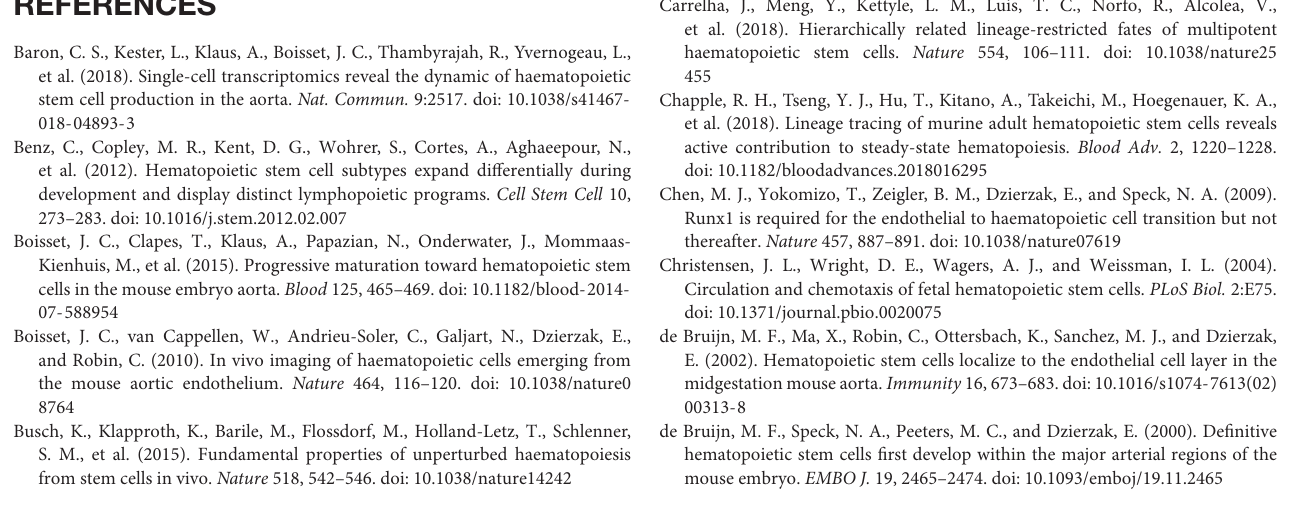
Supplementary Figure 2 | Representative FACS analyses of Hlf-tdTomato expression in embryos. (A) Representative FACS plots showing the proportions of Hlf-tdTomato + cells in hematopoietic cells (CD41 + /CD43 + /CD45 + ) and non-hematopoietic cells (CD41 − CD43 − CD45 − ) of the limb, head, and trunk from E10.5 Hlf-tdTomato embryos. Data are representative of two independent experiments. (B) Representative FACS plots showing no Hlf-tdTomato expression in PK44 (CD41 − CD43 − CD45 − CD31 + CD44 + Kit + CD201 + ) population of the E10.5 Hlf-tdTomato AGM region. Supplementary Figure 3 | Representative FACS analyses of multi-lineage repopulation in multiple organs. (A) Representative FACS plots showing multi-organ and multi-lineage repopulation in the recipients 16 weeks post-transplantation transplanted with the culture products of the indicated cell populations from the E10.5 AGM region. The myeloid cells (Gr1/Mac-1 + ), B cells (B220 + ), and T cells (CD3 + or CD4/CD8 + ) in multiple hematopoietic organs are shown. (B) Representative FACS plots showing the proportions of donor-derived cells (represented by CD45.1 + ) in hematopoietic stem progenitor populations in the bone marrow of the reconstituted recipients 16 weeks post-transplantation transplanted with the progenies of the indicated cell populations from the E10.5 AGM region. LSKSLAM marker combination was used. (C) Representative FACS plots showing multi-organ and multi-lineage repopulation in the recipient 16 weeks post-transplantation transplanted with the progenies of the indicated cell populations from the E10.5 AGM region. The myeloid cells (Gr1/Mac-1 + ), B cells (B220 + ), and T cells (CD3 + or CD4/CD8 + ) in multiple hematopoietic organs are shown. (D) Representative FACS plots showing the proportions of donor-derived cells (represented by CD45.1 + ) in hematopoietic stem progenitor populations in the bone marrow of the reconstituted recipient 16 weeks post-transplantation transplanted with the progenies of the indicated cell populations from the E10.5 AGM region. LSKSLAM marker combination was used. LT-HSC, long-term hematopoietic stem cell; ST-HSC, short-term hematopoietic stem cell; MPP, multipotent progenitor; CMP, common myeloid progenitor; GMP, granulocyte-monocyte progenitor; MEP, megakaryocyte-erythroid progenitor. Supplementary Figure 4 | Representative FACS analyses of lineage-traced cells in Hlf-CreER;ZsGreen mice. (A) Representative FACS plots showing the Hlf-labeled cells in endothelial cells (ECs), IAHCs, and T1 and T2 pre-HSCs in the AGM region of E11.5 Hlf-CreER;ZsGreen embryos with tamoxifen administrated at E9.5. Data are representative of six independent experiments. (B) Graph showing the dynamics of labeling in endothelial cells (ECs), IAHCs, and T1 and T2 pre-HSCs in the AGM region of E11.5 Hlf-CreER;ZsGreen embryos with tamoxifen administration at E9.5. Each line represents an individual embryo. (C) Representative FACS plots (left) and graph (right) showing the proportions of Hlf-labeled cells in the immunophenotypic HSCs (ESLAM) in the fetal liver (FL) of E15.5 Hlf-CreER;ZsGreen embryos with tamoxifen administration at E9.5. Data are representative of four independent